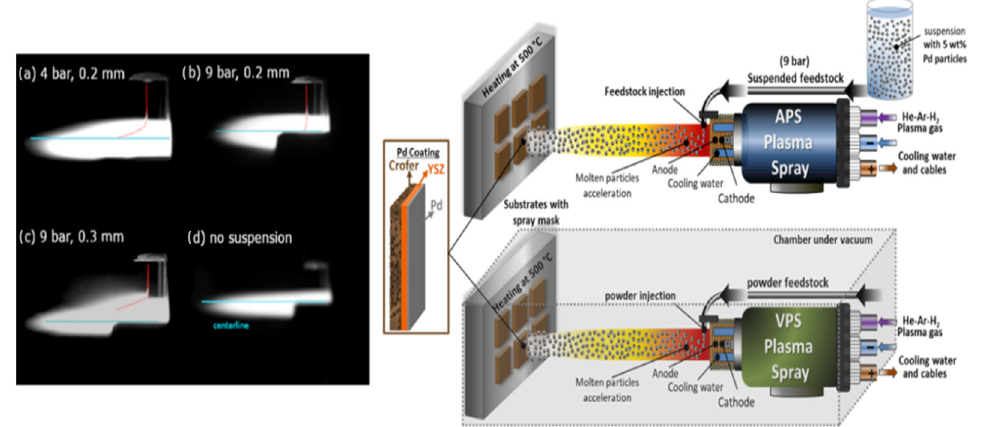
Figure 1. Left-hand side: CCD camera recordings of the injected water suspensions into the plasma flame ( a ) 4 bar, nozzle diameter of 0.2 mm, ( b ) 9 bar, nozzle diameter of 0.2 mm, ( c ) 9 bar, nozzle diameter of 0.3 mm, ( d ) plasma with no suspension as a reference. Right-hand side: schematics of the process for two techniques of APS and VPS in this study.